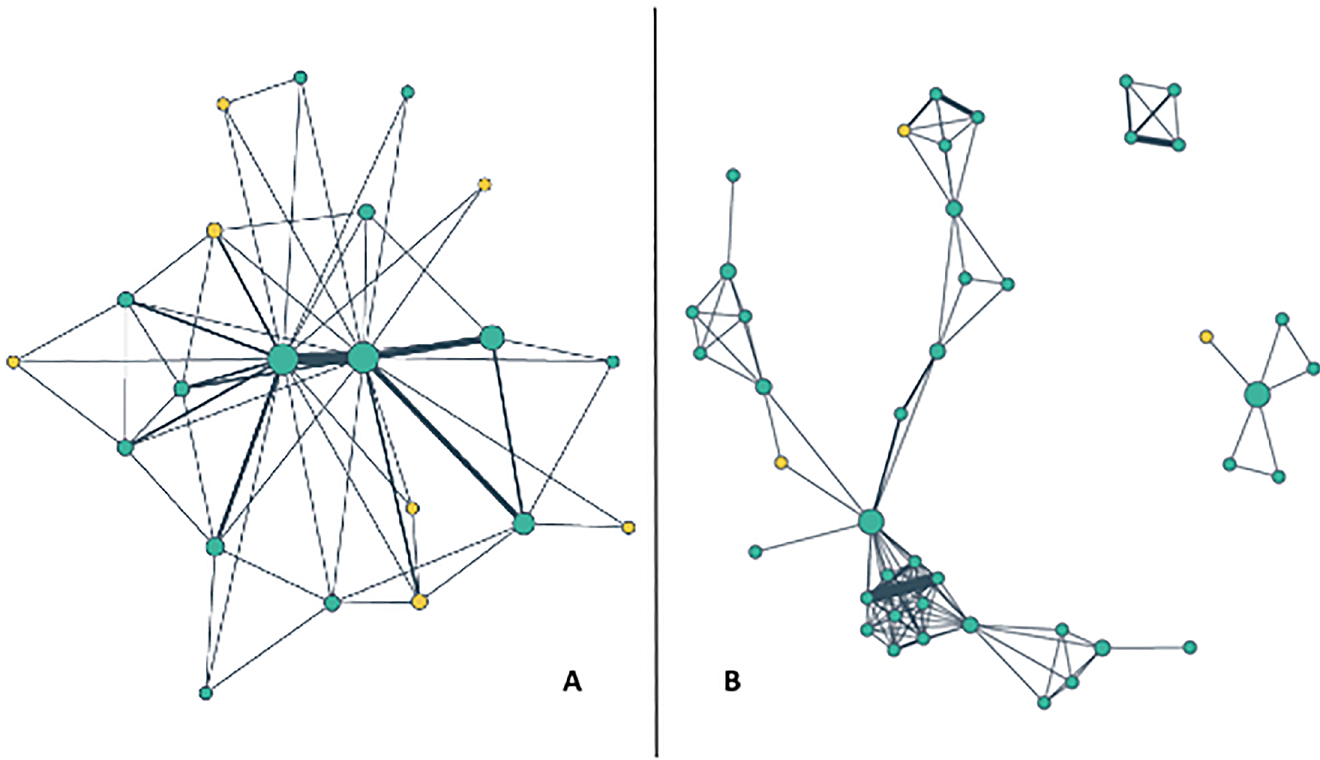
Fig 1. Physician networks in 2 California communities in 2011 with low (A) vs. high (B) concentration of blacks. (A) Hospital serving fewer black residents in HSA, % black = 0.00, clustering coefficient = 0.39, external ties = 7. (B) Hospital serving more black residents in HSA, % black = 0.13, clustering coefficient = 0.82, external ties =